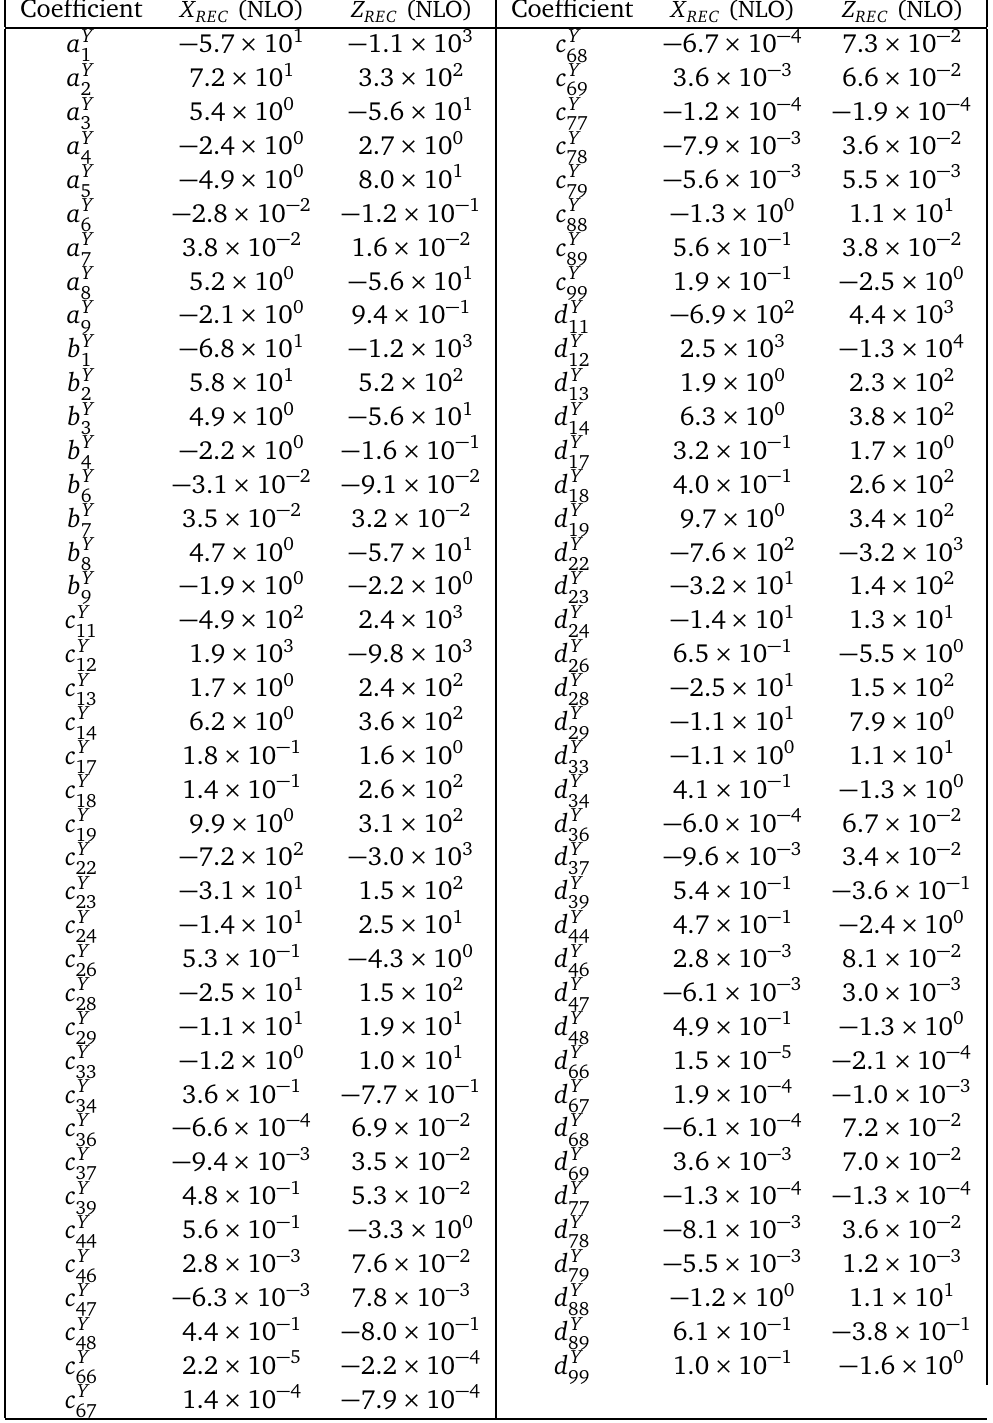
Table 4: Coefficients for the LM with the general basis expressed in Eq. (38) for both x and z momentum